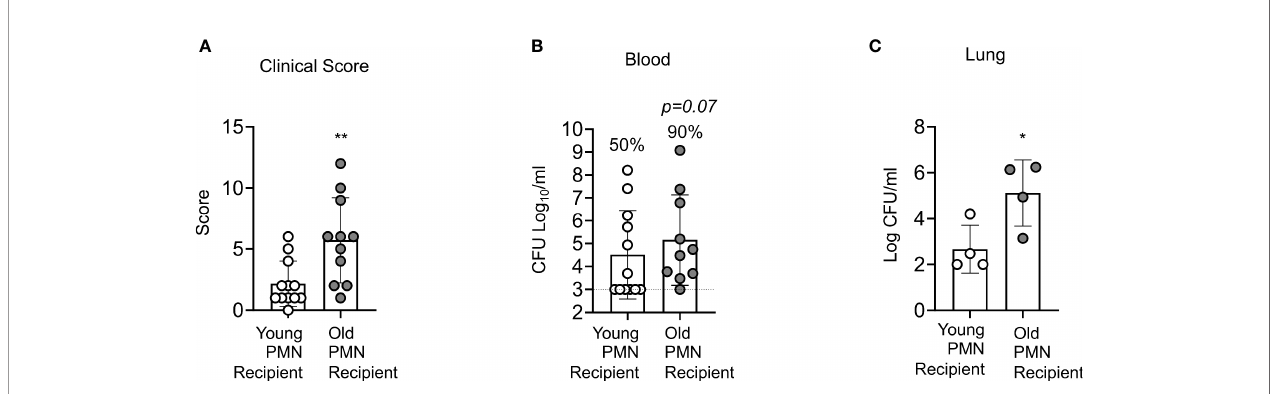
FIGURE 7 | Adoptive transfer of PMNs from young mice at the time of challenge rescues the susceptibility of vaccinated old mice to S. pneumoniae . Old male C57BL/6 mice were vaccinated with Prevnar-13, four weeks post vaccination mice were adoptively transferred 2.5x10 6 PMNs from either naïve young or naïve old mice. One hour post transfer, mice were infected i.t. with 1x10 6 CFU of S. pneumoniae and clinical score (A) as well as bacterial numbers in the blood (B) , and lung (C) were determined 18 hours post infection. (B) Fractions indicate the percent of mice that were bacteremic. Asterisks indicate signi fi cant differences calculated by unpaired Student ’ s test (A, C) and Fisher ’ s exact test (B) . Data pooled from n=11 mice per group (A, B) or n=4 (C) mice per group are shown. * denotes p < 0.05, and ** denotes p < 0.01